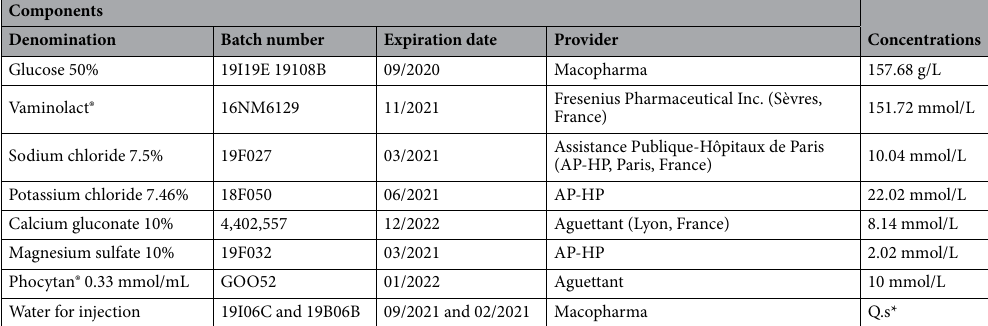
Table 1. Composition of standard parenteral nutrition solution. * Q.s quantity